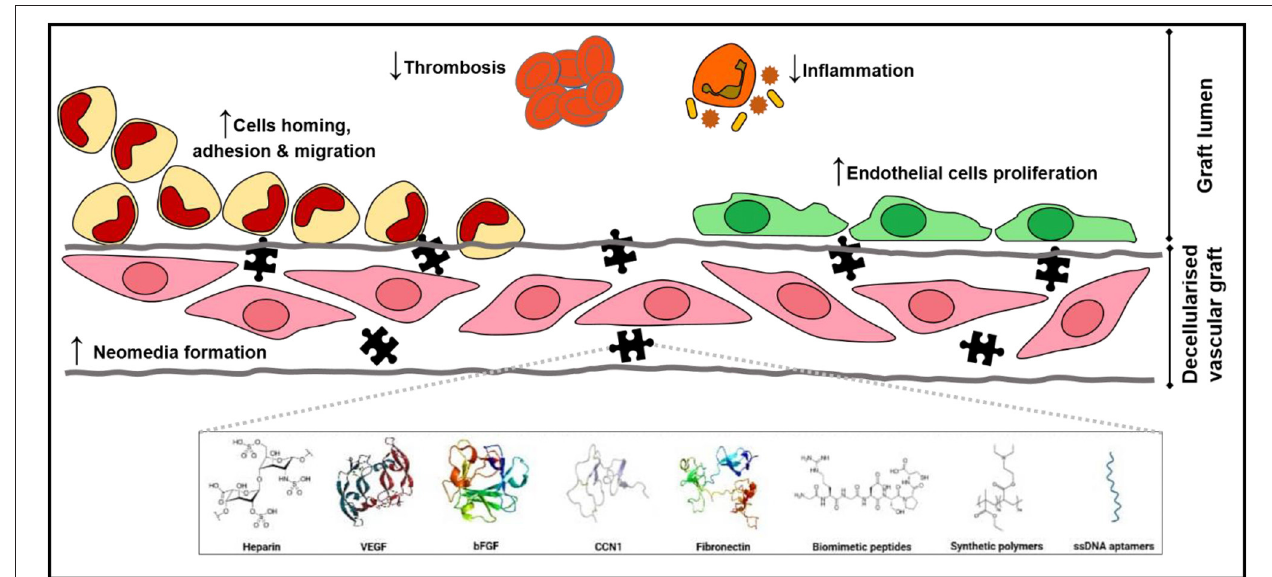
FIGURE 2 | The missing puzzle piece. Coatings of decellularized vascular graft present a myriad of positive effects that promote cell adhesion, migration, and proliferation both on the luminal surface, enhancing reendothelialization, and in the decellularized vascular graft, establishing a neomedia that consequently strengthens mechanical properties of the graft. Coatings also halt thrombosis and reduce inflammatory reactions.